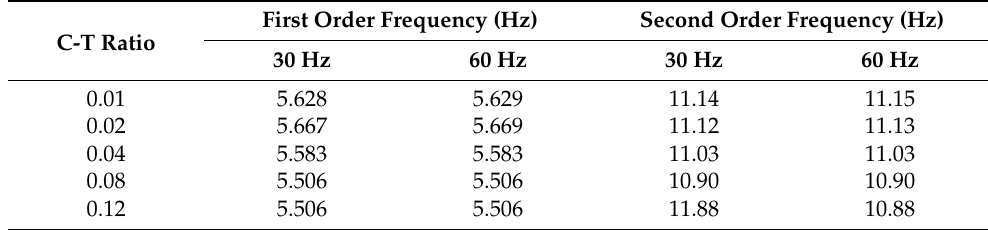
Figure 19. Frequency domain diagrams of the vibrating cable in five videos with 30 Hz sampling frequency (top to bottom, left to right, C-T ratio is 0.01, 0.02, 0.04, 0.08, 0.12, respectively). Table 22. First two order frequencies derived from videos with sampling frequency of 30 Hz and 60